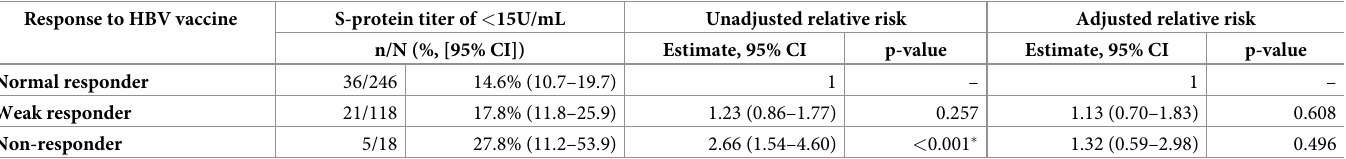
Table 3. Log-binomial regression for the unadjusted and adjusted relative risk non-seroconversion (anti-SARS-CoV-2 spike protein antibody level of < 15 U/mL) after a single dose of BNT162b2 mRNA-1273 COVID-19 vaccine by history of HBV vaccine response among a subset of patients with baseline comorbidity data (n =